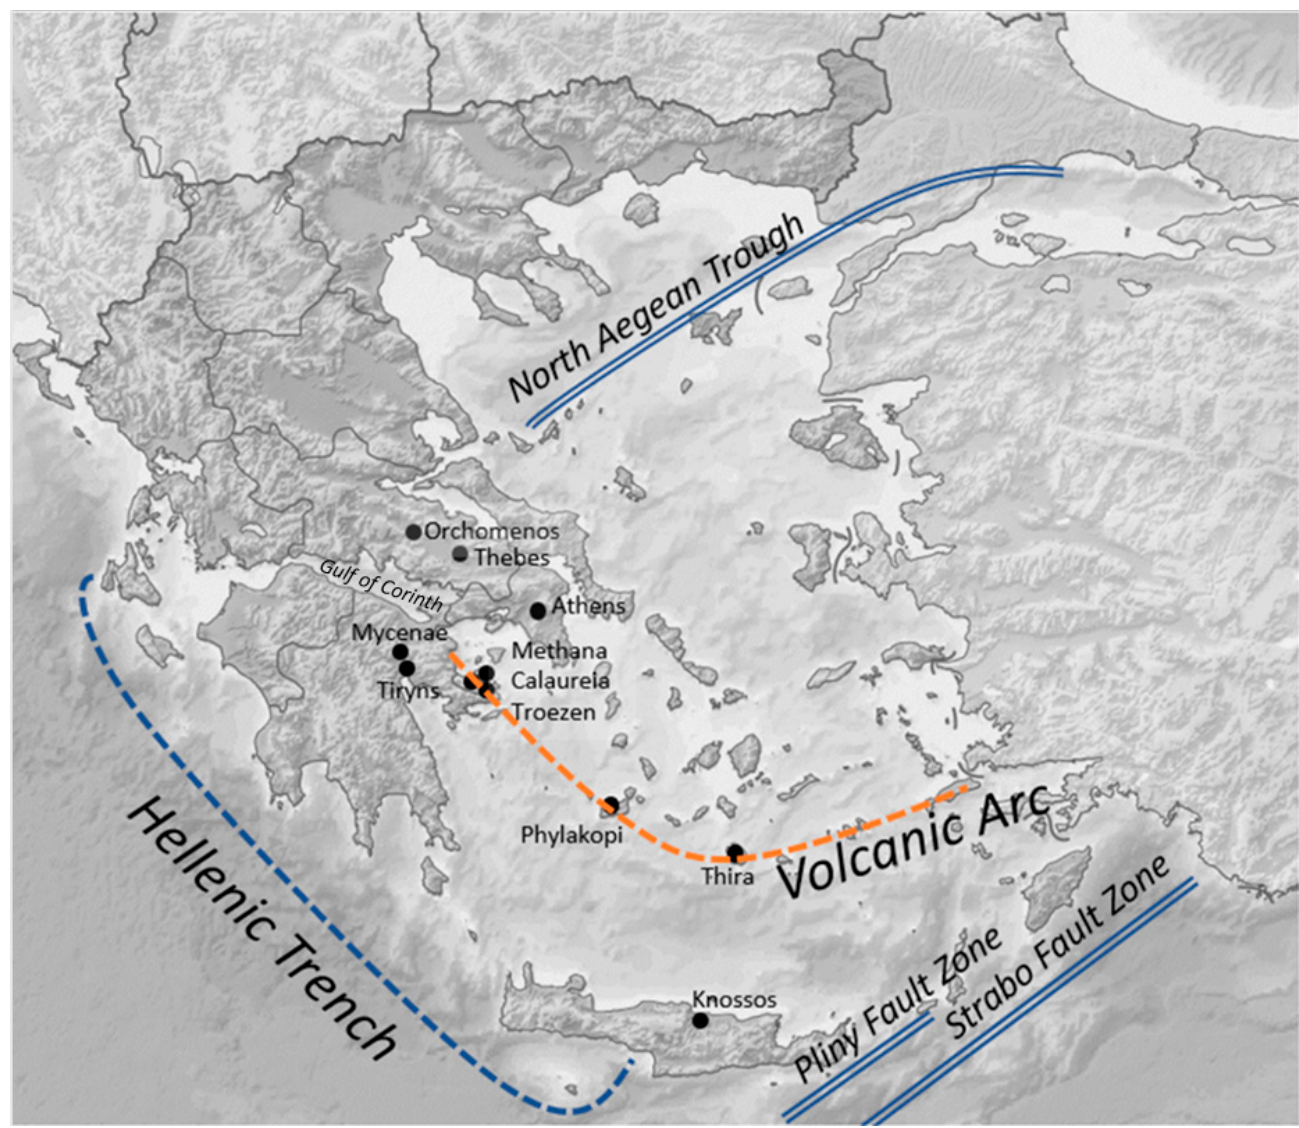
Figure 3. The Volcanic Arc and the Hellenic Trench in Greece with sites mentioned in the text. The Aegean Sea Plate (also called the Hellenic Plate or Aegean Plate) is a minor tectonic plate in the eastern Mediterranean Sea under southern Greece and far western Turkey. Its southern edge is a subduction zone south of Crete, where the African Plate is swept under the Aegean Sea Plate. Seismic and volcanic centers lie along the euro-african subduction zone. The Volcanic Arc (orange dashed line) of the northern Eurasian Plate is a divergent boundary responsible for the formation of the Gulf of Corinth. Note the northern Aegean Trench, the Hellenic Trench, and Pliny and Strabo fault zones in eastern Crete (based on [54,55], scale: Athens-Thebes = 205 km (Basemap: United States National Imagery and Mapping Agency data).